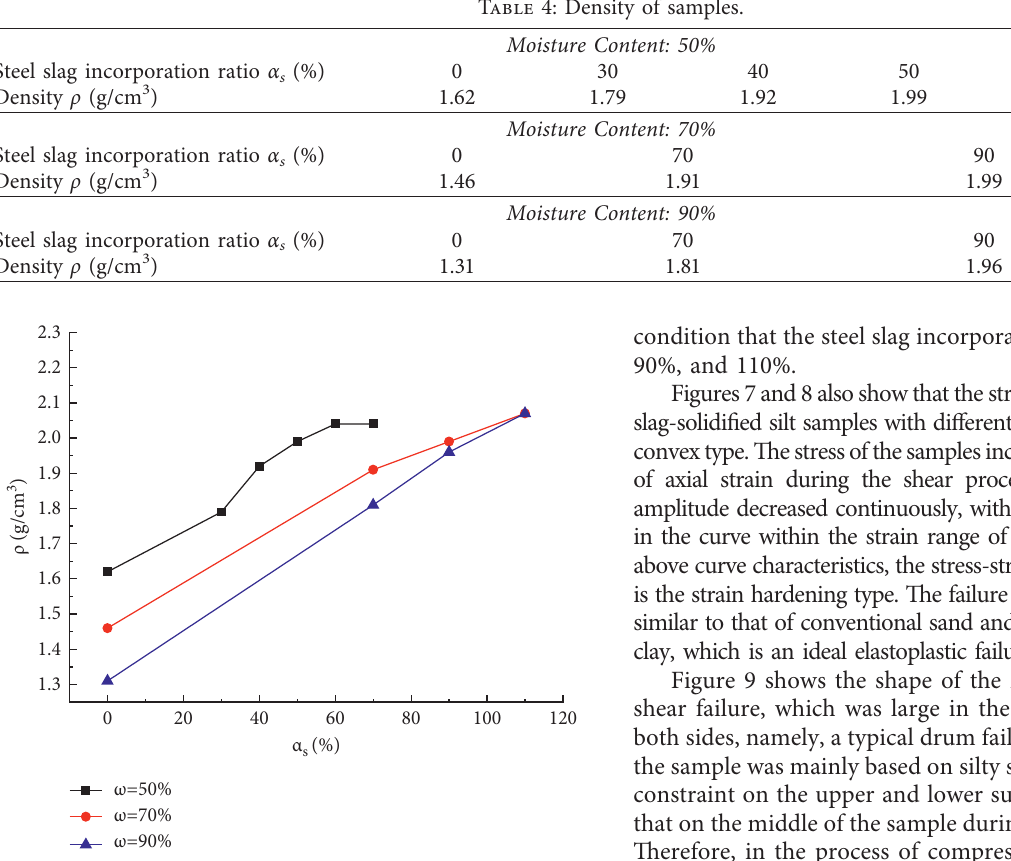
Figure 5: Density of the